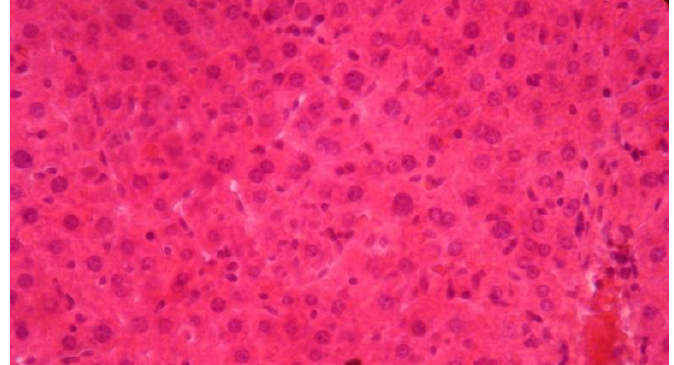
Fig. 2. Severe hepatocyte swelling and nucleated chromatin variations (magnification 400) under the influence of engine oil containing 5000 mg/kg copper nanoparticles.